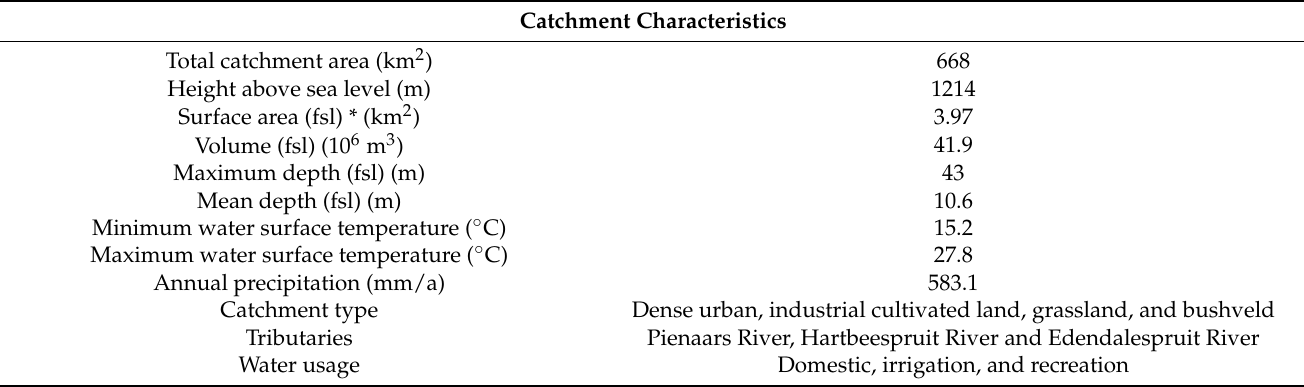
Table 1. Summary of the catchment characteristics of Roodeplaat Dam (adapted from [38,39,42]). Catchment